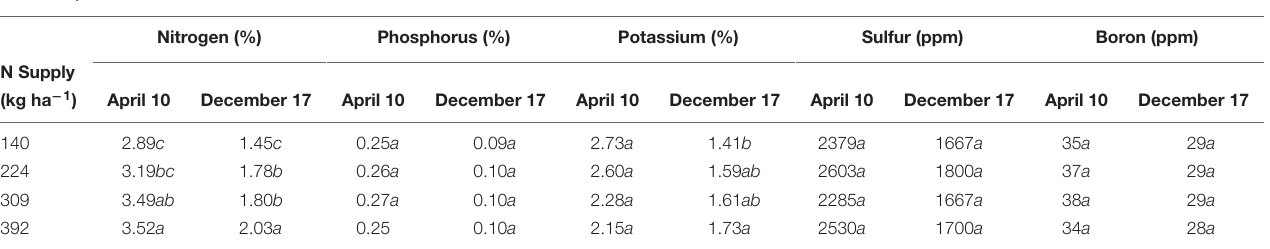
TABLE 9 | Mean seasonal maximum and minimum concentrations of N, P, K, S, and B in leaves in